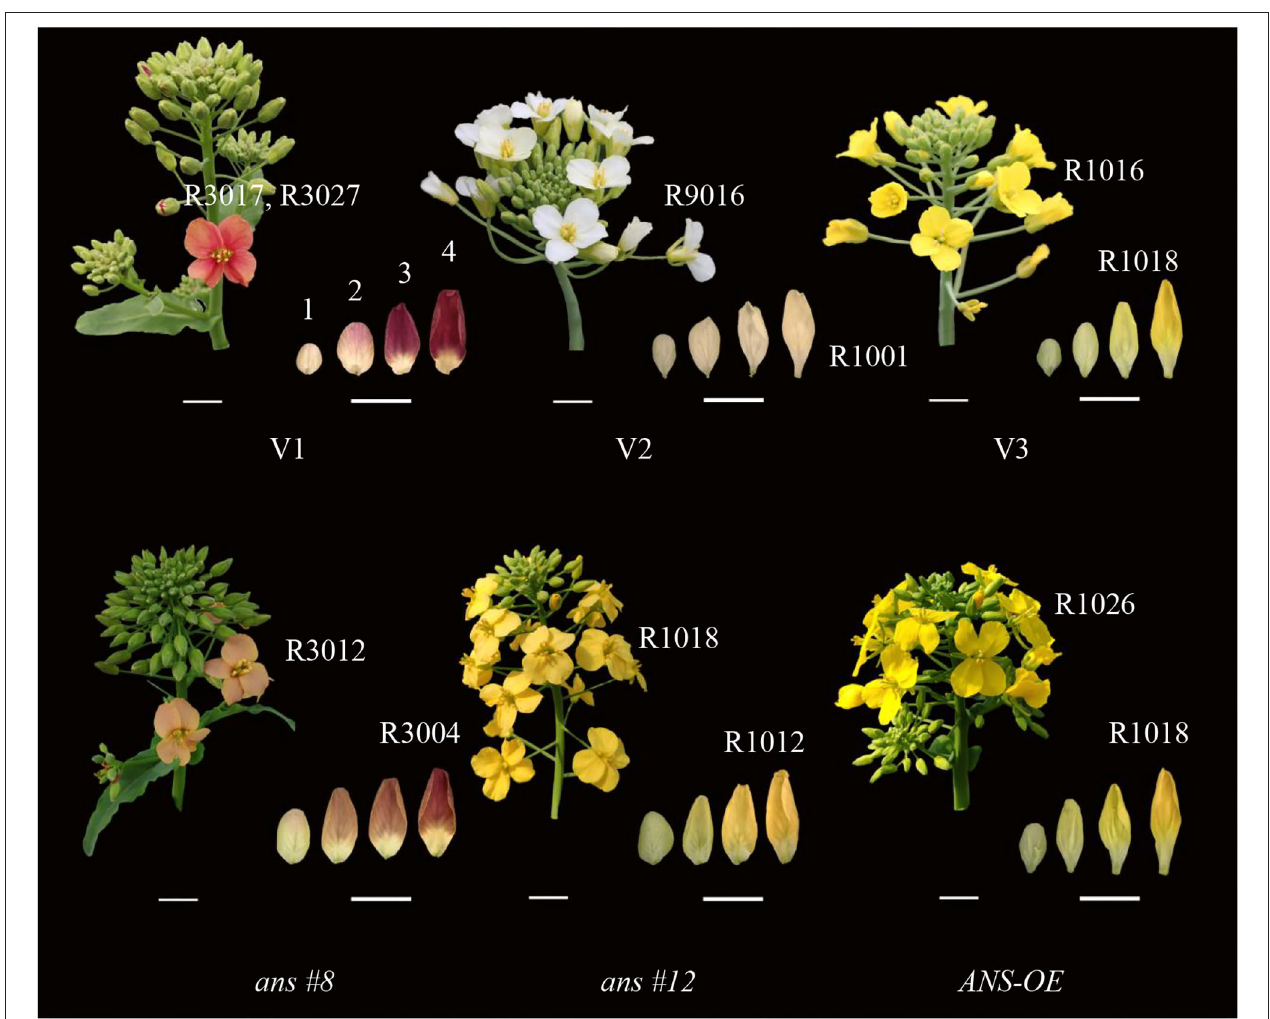
FIGURE 1 | Inflorescence individuals and unopened petals phenotypes of Brassica napus with red (Zhehuhong, V1), white (Zhehubai, V2), yellow (Zheyou 50, V3) color, and the transgenic lines ( ans#8 and ans#12 indicated RNAi-1 and RNAi-2 plants; ANS-OE indicated overexpression plants). Numbers on the top of unopened petals in V1 represented 4 development stages. R numbers represent colors alignment to RAL methods. Bars at the left bottom represent 1cm and bars at the right bottom represent 0.5cm.